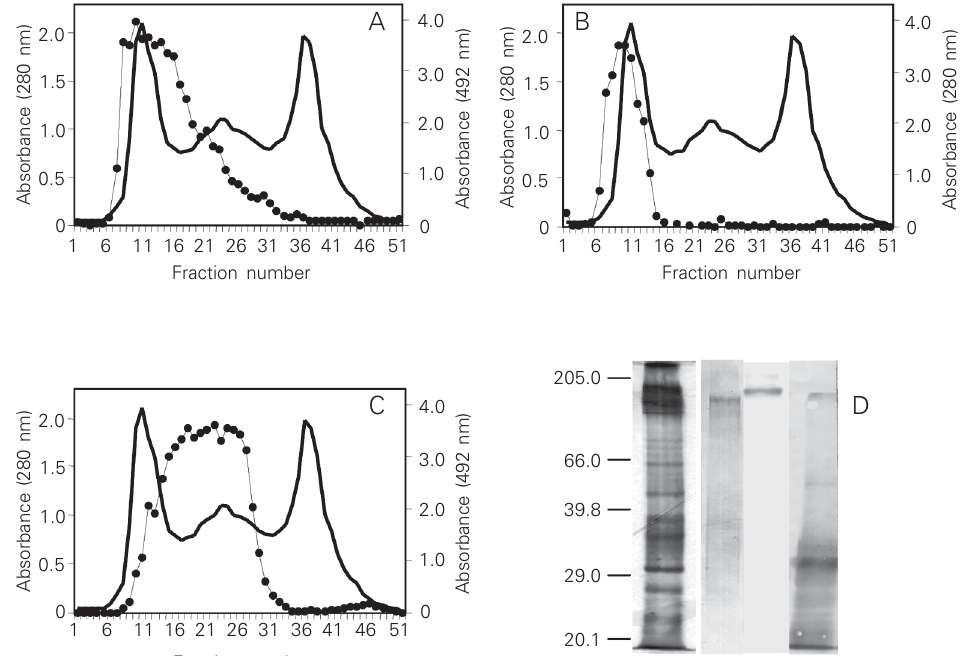
Figure 1. Specificity of MAIP-1, MAIP-2 and MAIP-3. The speci- ficity of each monoclonal anti- body was determined by ELISA using plates coated with each fraction of Ascaris suum extract isolated by gel filtration (Sephacryl S300). The chroma- tography effluent (solid line) was monitored by absorbance at 280 nm and the binding of MAIP-1 (A), MAIP-2 (B) and MAIP-3 (C) was visualized using a peroxi- dase-labeled rat anti-mouse κ chain (closed circles). The SDS- PAGE pattern of Ascaris suum whole extract is represented in D , lane 1 . Immunoblotting of Ascaris suum components us- ing MAIP-1 ( lane 2 ), MAIP-2 ( lane 3 ) or MAIP-3 ( lane 4 ) was performed with a peroxidase-la- beled anti- κ light chain. The mo- lecular mass markers listed on the left are in